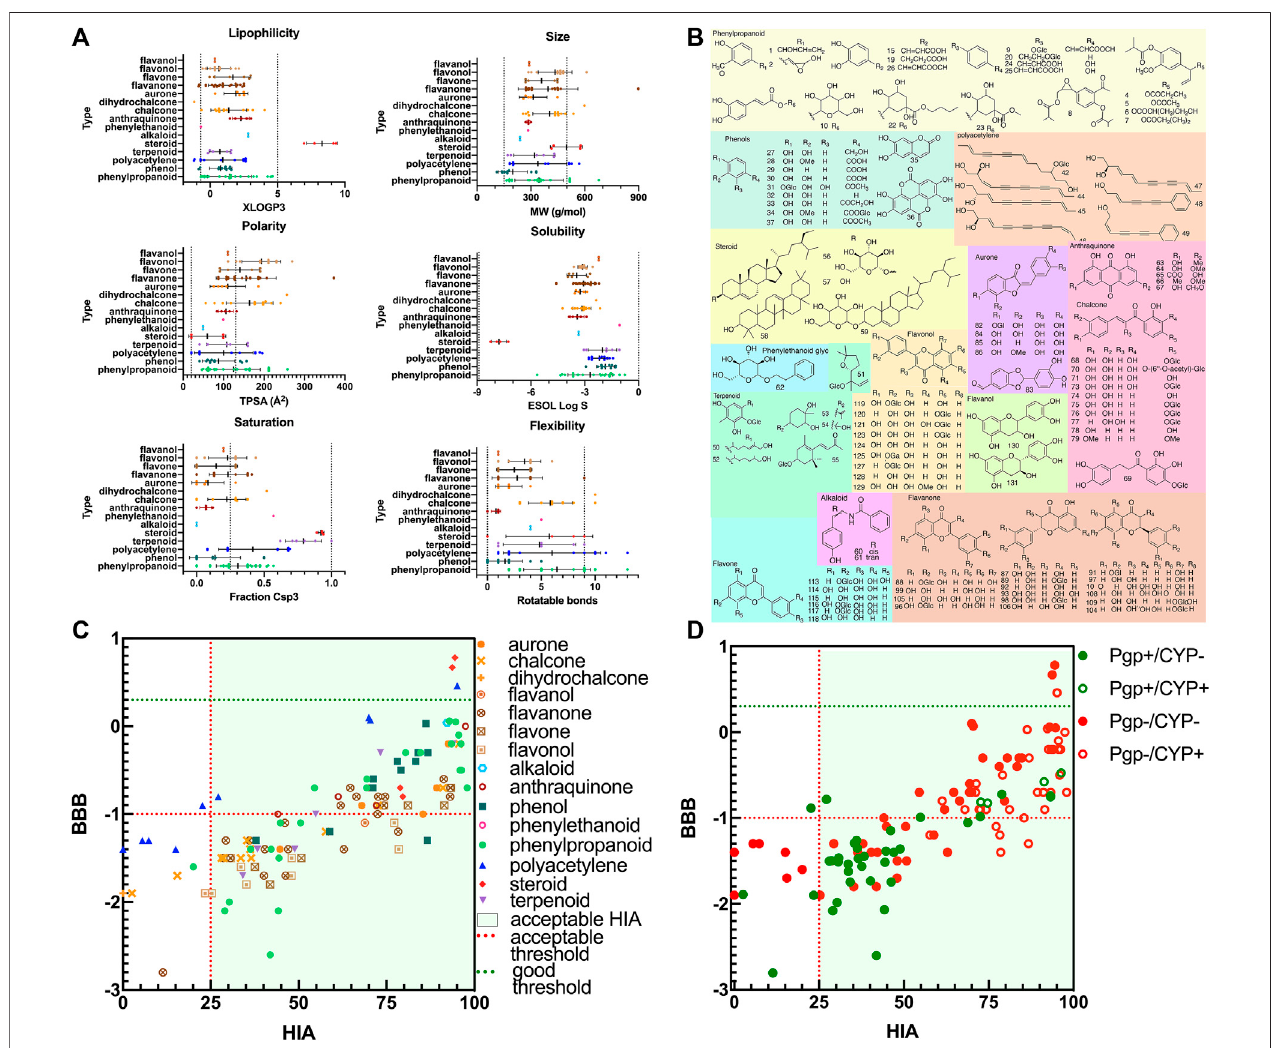
FIGURE 2 | The drug-likeness properties and structures of compounds in CT. (A) Six physicochemical properties for evaluation of bioavailability (lipophilicity, size, polarity, solubility, fl exibility, and saturation). (B) The 2D molecular structures of candidate compounds, (C) ADME properties (HIA and BBB), and (D) ADME properties (substrates for P-gp or CYP